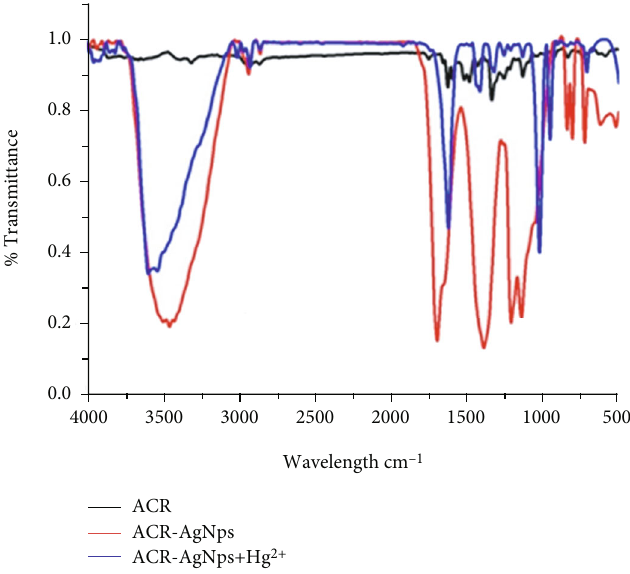
Figure 11: FTIR spectra of ACR, ACR-AgNPs, and ACR-AgNPs complex with Hg 2+